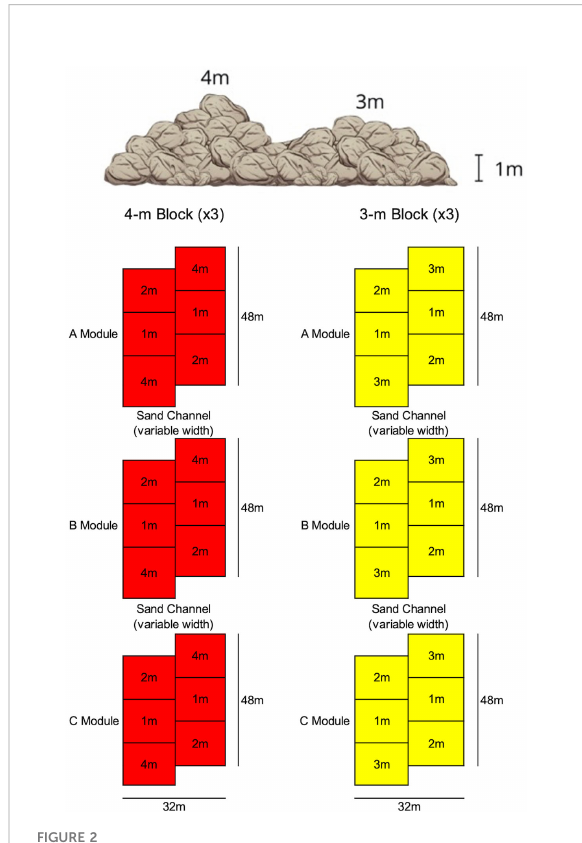
FIGURE 2 Basic schematic diagram of the restoration reef